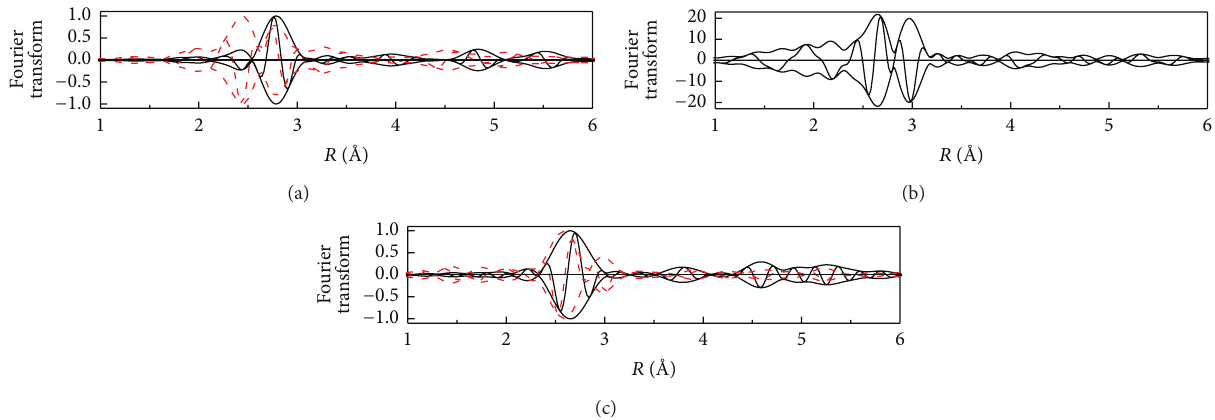
−1 , Pt-Pt phase −1 , −1 , Ru-Ru phase and